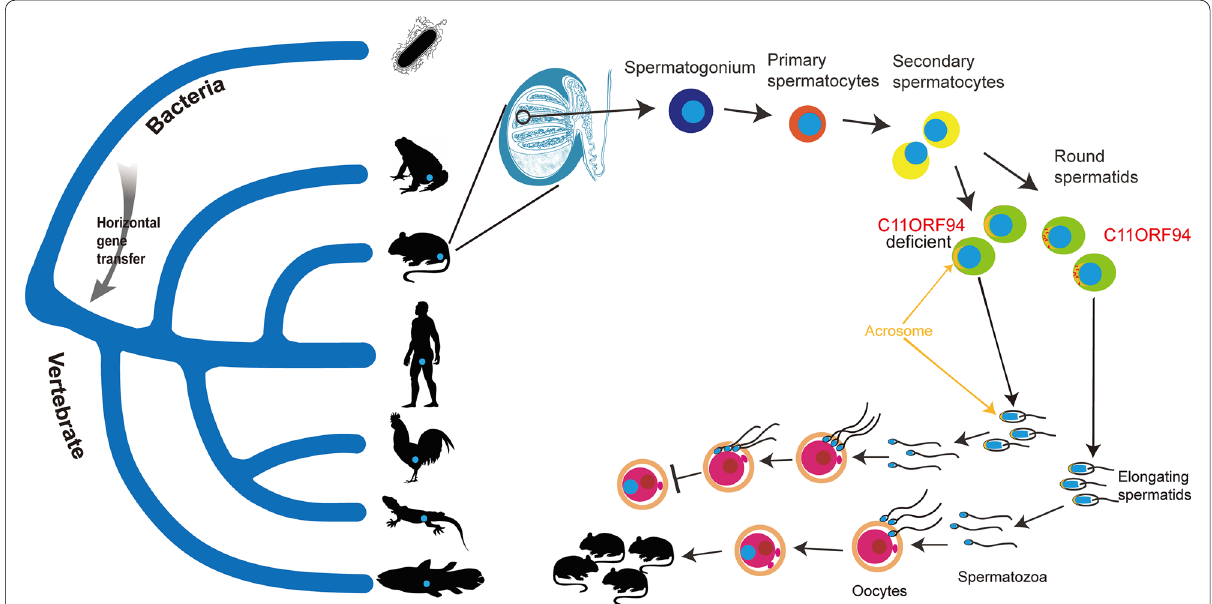
Fig. 9 Diagram of C11orf94 origin and function in mice. The emergence of C11orf94 in vertebrates presumably occurred by horizontal transfer from a bacterial genome and C11orf94 is conserved in all vertebrates. Its protein products are mainly located on the membrane surface of round spermatids in the testis and disappears from the mature sperm membrane. The absence of C11ORF94 protein allows sperm to cross the zona pellucida but it accumulates in the perivitelline space and is unable to penetrate the oolemma. Animal profiles were downloaded from PHYLOPIC (http:// phylo pic. org/ image/